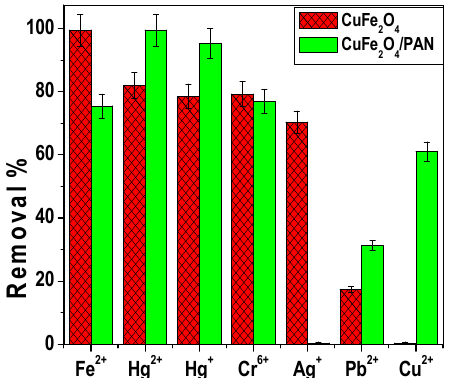
Figure 10. Removal of different metal ions with CuFe 2 O 4 and CuFe 2 O 4 /PANI nano-composite.